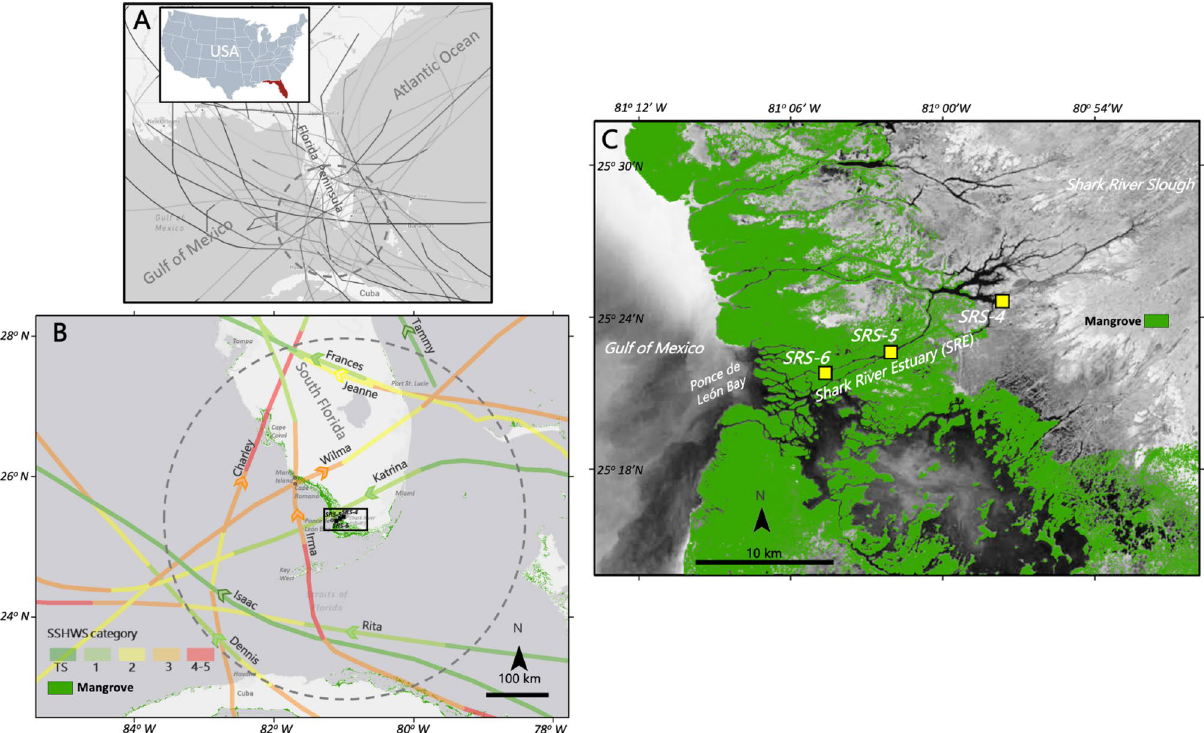
Figure 2. (A ) Tropical cyclone trajectories (N = 28) in the Gulf of Mexico and Atlantic Ocean around the Florida Peninsula, USA from 1990–2018 including those that passed within a 300 km-radii (dotted circle center: Lat 25°22 ′ 37.20"N, Long 81° 1 ′ 55.20"W) from the mangrove study sites along the Shark River Estuary (SRE) in the Everglades, South Florida. ( B) Selection of eight cyclones impacting study sites included in the analysis of Litterfall Net Primary Productivity (NNP L ). Tropical cyclones Rita and Tammy are shown to indicate the relative impact on the study area depending on trajectory and distance to the study sites (see “Discussion”). ( C) Location of mangrove study sites (SRS-4, SRS-5, SRS-6) along the Shark River Estuary (SRE). SSHWS Saffir-Simpson Hurricane Wind Scale. Mangrove coverage data is available as part of the Global Mangrove Watch (GMW) project 17 ); track data is available from the National Hurricane Center (see “Methods” for details). Panels B and C were created using ArcGIS Desktop 10.8.1 mapping